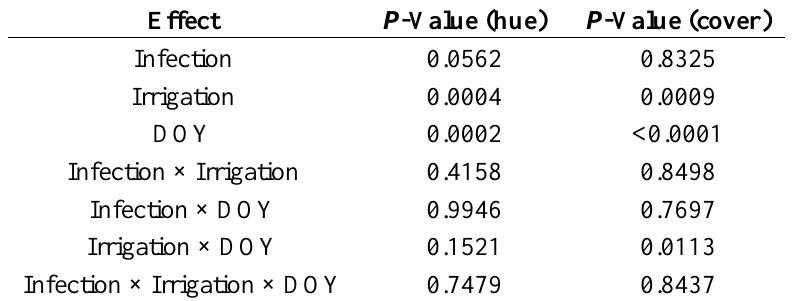
Table 1. Tests of fixed effects for 2011 wheat EM-based hue and cover fraction (N = 120).